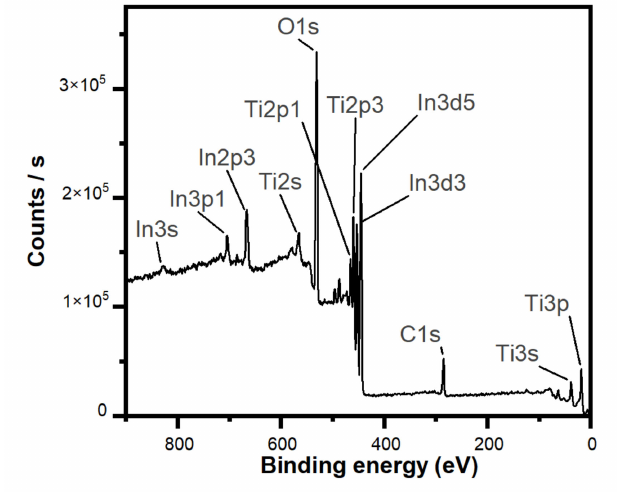
Figure 4. XPS survey of TiO 2 -GC, representative of all samples including